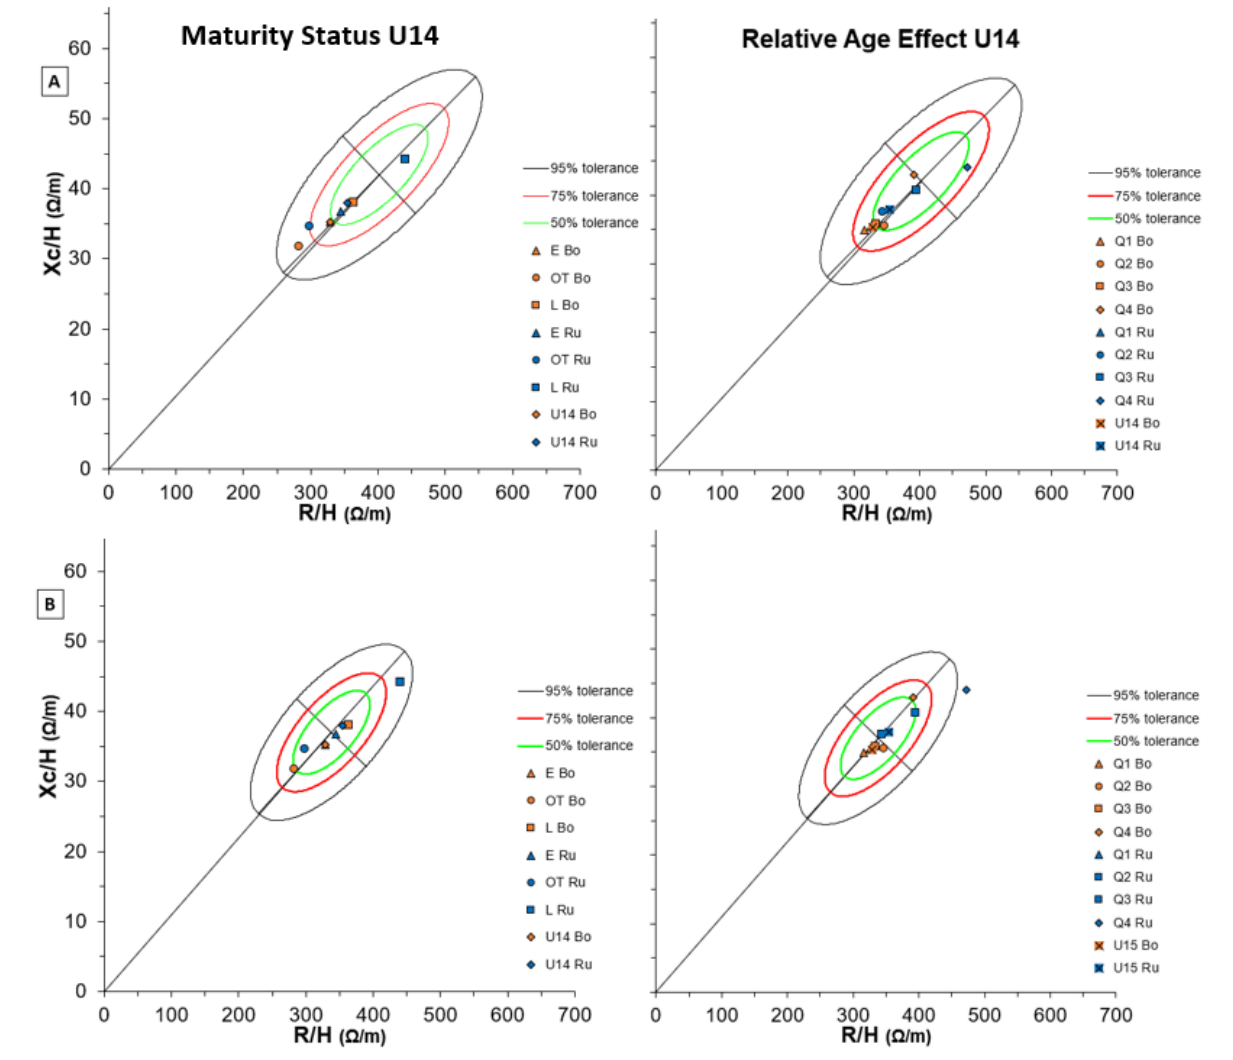
Figure 8. BIVA tolerance with Maturity Status (left) and Relative Age Effect (right) of both Bologna and Russi U14 groups for two reference populations: ( A ) number 116 (males, white, age 13 years, BMI 19, Italy, Akern-RJL Systems); ( B ) number 118 (Males + Females, White, age 14–15 years, BMI 20, Italy, Akern-RJL Systems). Note: U15 Bo and U15 Ru refer to team means respectively.